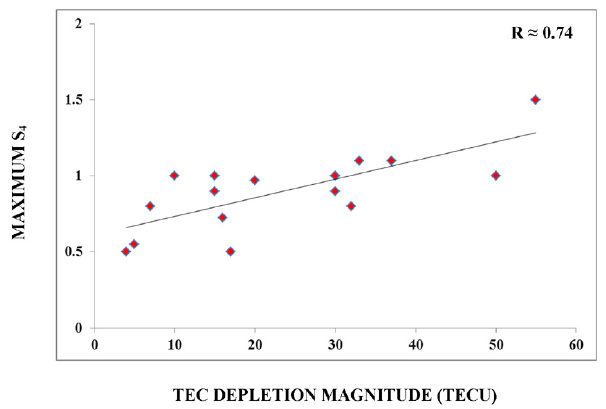
Fig. 10. Variations of depletion magnitude in TEC and maximum S 4 indices as observed on GPS tracks. A highly significant correlation ≈ 0 . 74 between the two is reflected.